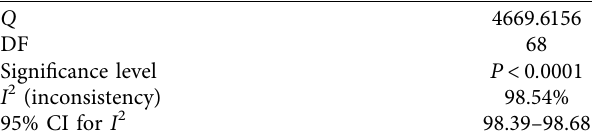
Table 3: Test for heterogeneity for the prevalence of Brucella spp.